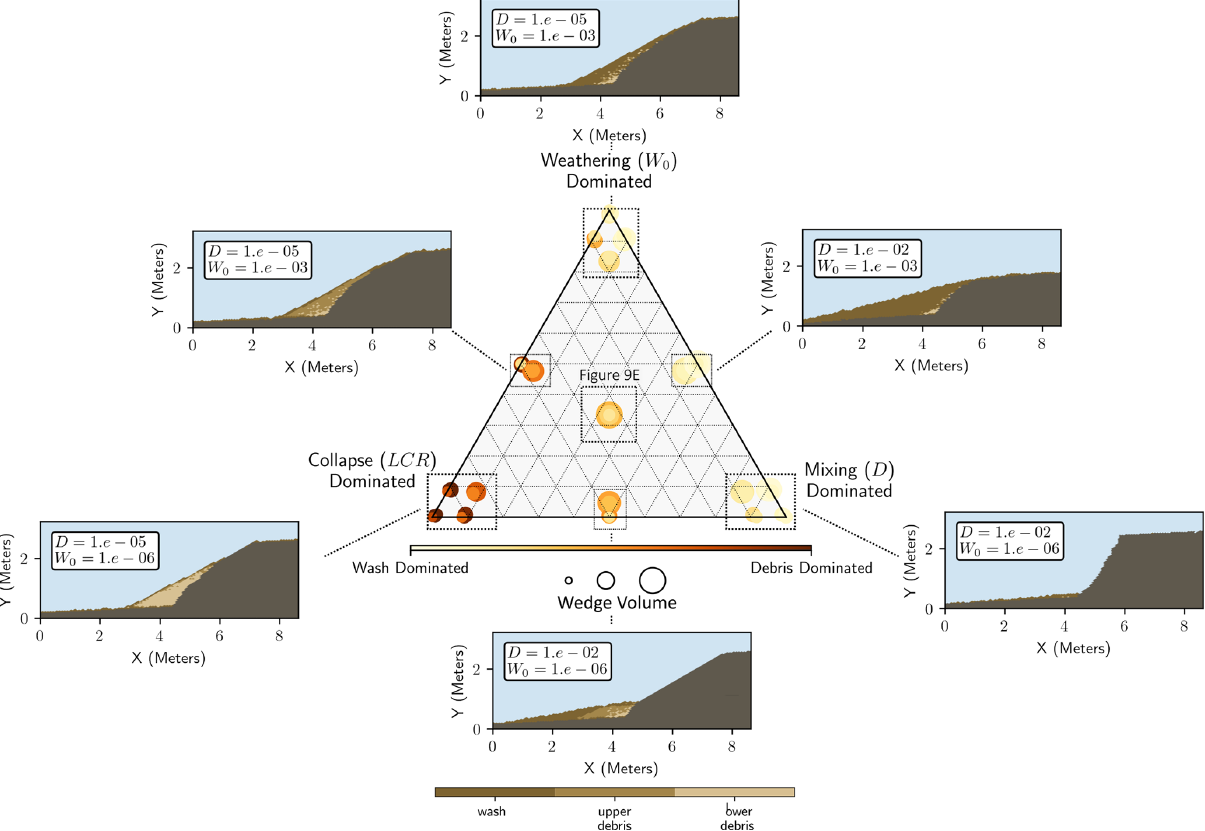
Figure 11. Summary ternary diagram of the effects of geomorphic processes on colluvial wedge morphostratigraphy for the 60 ◦ fault model. Ternary axes are plotted as X/ (LCR + W 0 + D ), where X is the axis variable (LCR , W 0 D ). The color and size of points are scaled by relative quantity of facies and colluvial wedge size. The inset model runs show representative examples of wedges resulting from plotted parameter